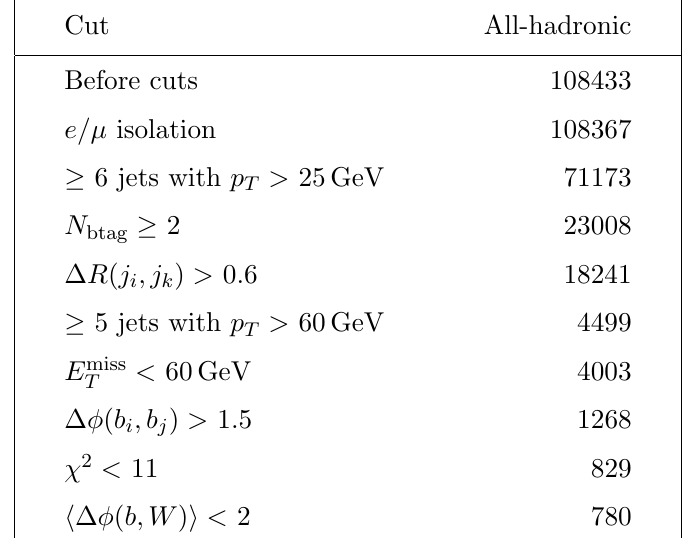
Figure 13 . Two validation plots are provided for the all-hadronic channel. Three-jet invariant mass distributions for top candidates (left) and di-jet invariant mass for W -boson candidates (right), assuming m t = 172 : 5 GeV. The blue distributions correspond to our simulation and the orange dots represent the ATLAS results [12], which have been rescaled to so that the normalizations agree.